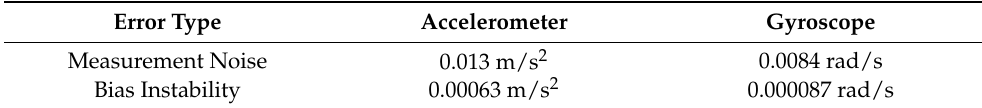
Table 2. Settings of artificial measurement noise and bias